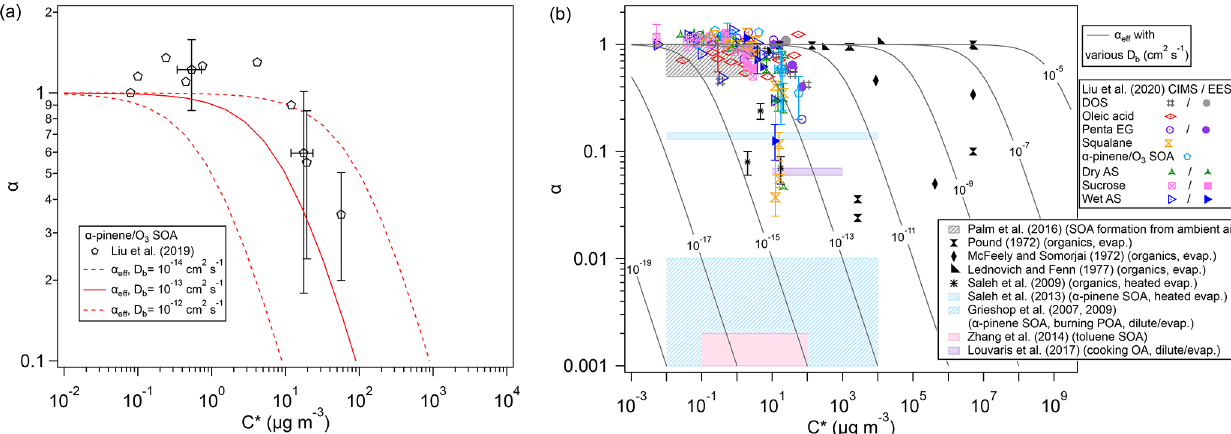
Figure 4. Effective mass accommodation coefficients, α eff (lines, Eqs. 5–10) compared to measurement-derived mass accommodation coef- ficients, α (data points/shaded areas, Eqs. 1–2), plotted against effective saturation mass concentration, C ∗ , for various SOA and surrogate systems assuming α s = 1, ω = 2 × 10 4 cms − 1 , ρ p = 1gcm − 3 , r p = 100nm, and C 0 = C ∗ . (a) Observational results from laboratory ex- periments with semi-volatile components of SOA generated by ozonolysis of α -pinene (data points, Liu et al., 2019) compared to α eff for D b = 10 − 14 to 10 − 12 cm 2 s − 1 (lines). (b) Observational results from earlier experimental investigations of laboratory-generated and ambi- ent samples (data points/shaded areas, compiled by Liu et al., 2019) compared to generic values of α eff for D b = 10 − 19 to 10 − 5 cm 2 s − 1